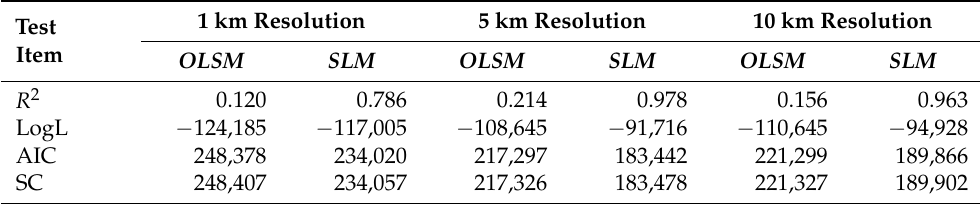
Table 2. Statistical test results for the SLM and OLSM